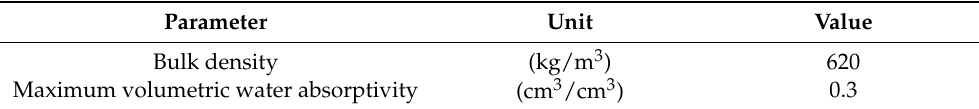
Table 1. Basic moisture parameters of aerated autoclaved aerated concrete applied in the experiment were determined according to standard [46].